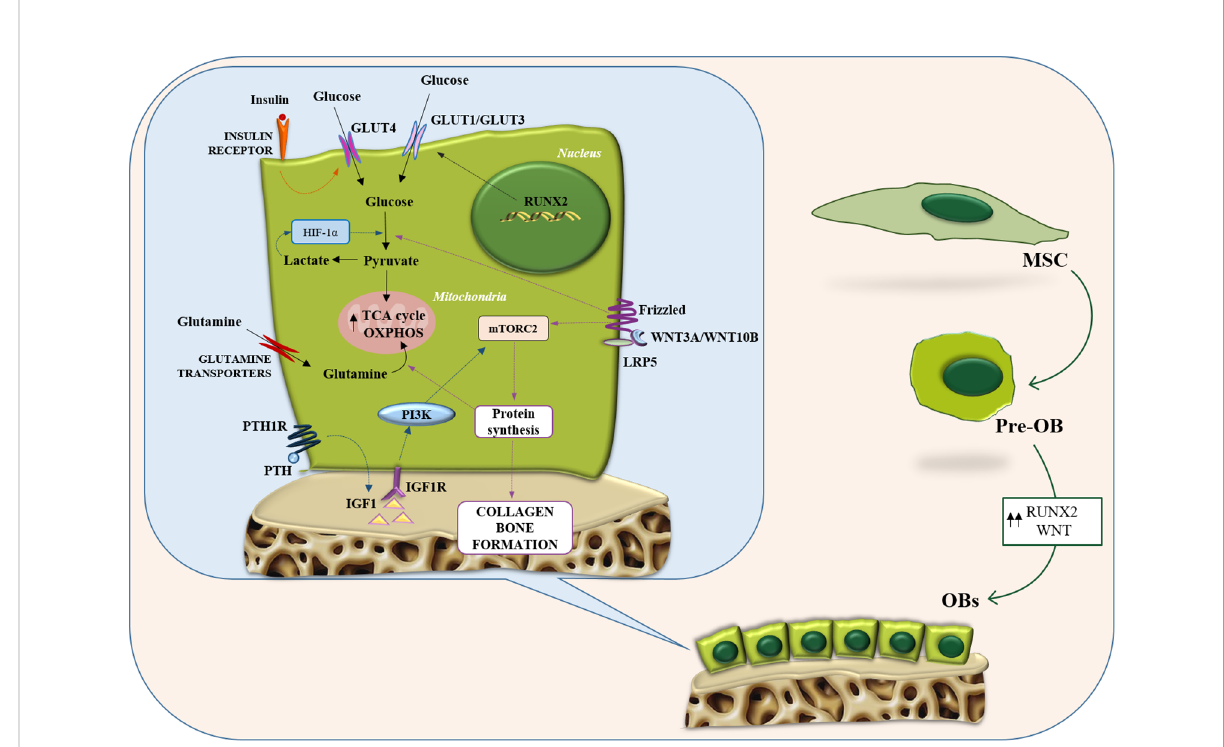
FIGURE 1 Metabolic features of osteoblasts. Representation of the main metabolic pathways in osteoblasts: glycolysis and glutamine metabolism. Intracellular energy metabolism relies on different feed-forward and negative feedback mechanisms. Osteoblasts take advantage of glucose metabolism to generate ATP through aerobic/anaerobic glycolysis or OXPHOS. Similarly, glutamine metabolism fuels the TCA cycle and boosts the OXPHOS pathway to generate additional ATP. GLUT, glucose transporter; HIF1- a , hypoxia-inducible factor-alpha; IGF-1, insulin-like growth factor-1; IGF1R, insulin like growth factor 1 receptor; LRP5, LDL receptor related protein 5; MSC, mesenchymal stromal cells; mTORC2, mTOR complex 2; OB, osteoblast; OXPHOS, oxidative phosphorylation; PI3K, phosphatidylInositol 3-kinase; PTH, parathyroid hormone; PTH1R, parathyroid hormone 1 receptor; RUNX2, runt-related transcription factor 2; TCA, tricarboxylic